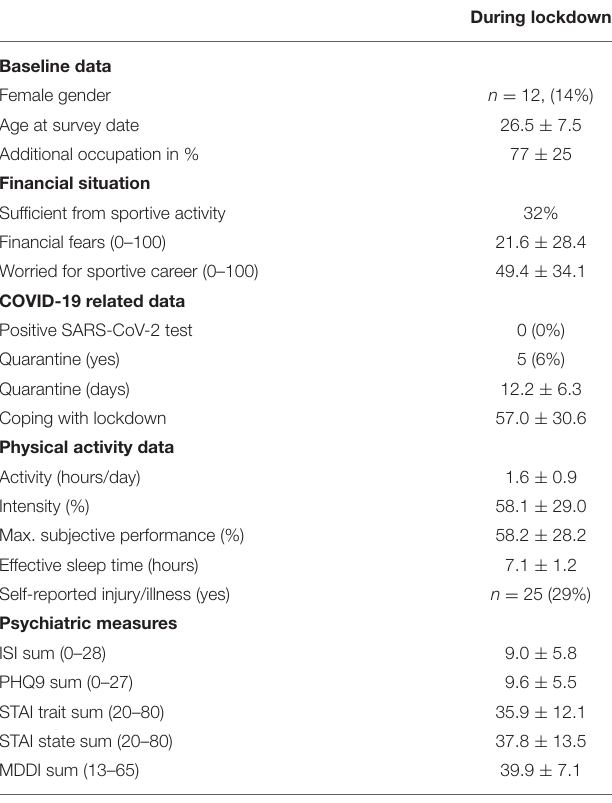
TABLE 1 | Data of bodybuilders and fitness athletes (BoFA) during lockdown ( N = 87).